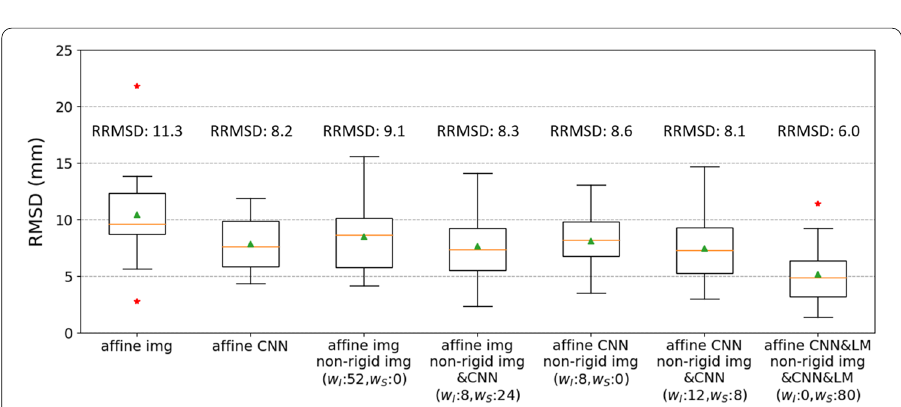
Fig. 6 RMSDs and RRMSDs of the test datasets (14 floating CT images) for comparison of image-based, CNN-guided, and CNN&LM-guided CT to CT